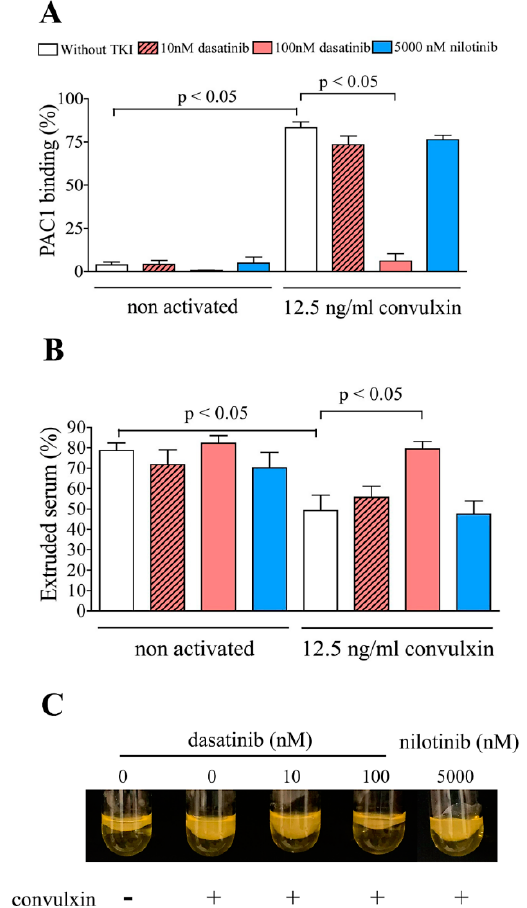
Figure 2. Inhibitory effect of dasatinib on convulxin-induced integrin α IIb β 3 activation and clot retraction. Platelets in control PRPs were pretreated with dasatinib/nilotinib or vehicle (without